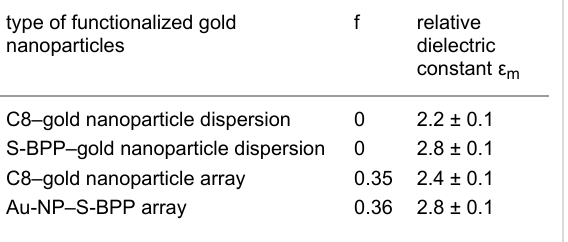
Table 1: Relative dielectric constant due to the ligands ε m (octanethiols vs BPP ligands) as calculated from UV–vis spectra of both nanoparticle solutions and nanoparticle arrays.